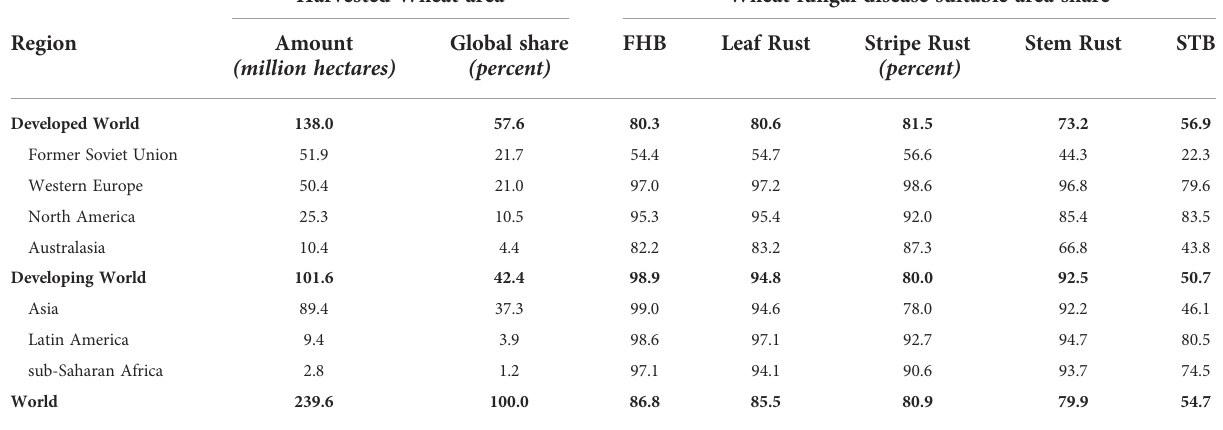
TABLE 1 Share of regional wheat growing areas at risk from fungal